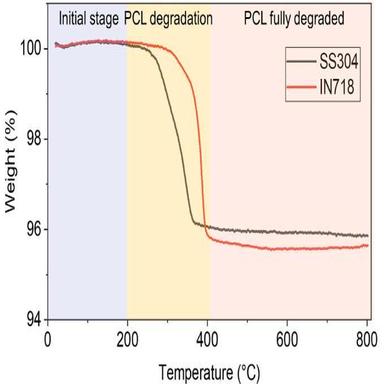
TGA analysis of the SS304 and IN718 powder sheets.